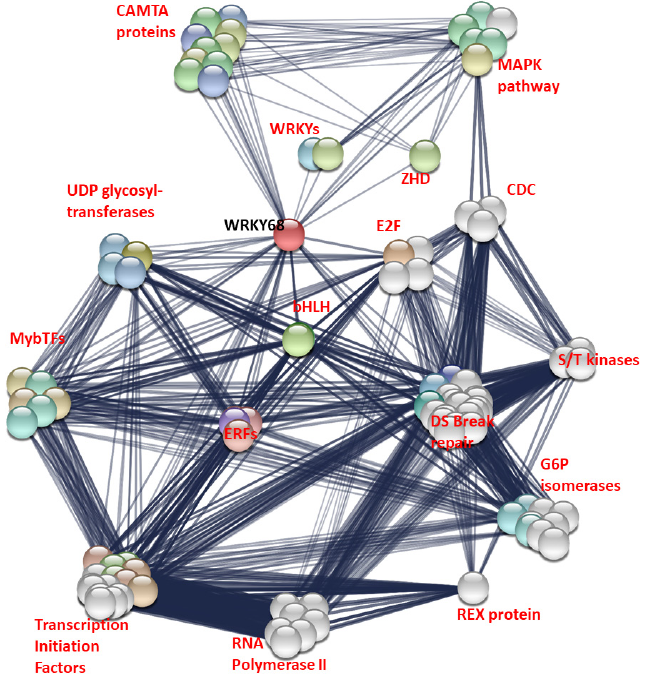
Figure 5. Interaction map of WRKY68a. Coloured nodes represent proteins known or predicted to interact with WRKY68a. White nodes represent proteins known to interact with those proteins. Edges represent a known or predicted interaction. The thickness of the edge indicates the strength of evidence for the interaction. Proteins are grouped into families or pathways for simplicity. CAMTA = calmodulin transcription activation factors, MAPK = nitrogen activated protein kinase, ZHD= zinc finger homeobox domain proteins, CDC = cell division cycle proteins, S/T = serine/ threonine, bHLH = basic helix-loop-helix, ERFs = ethylene response factor, DS Break repair = double strand break repair proteins, including RAS51, FHA, NBS1 and BRCA proteins.